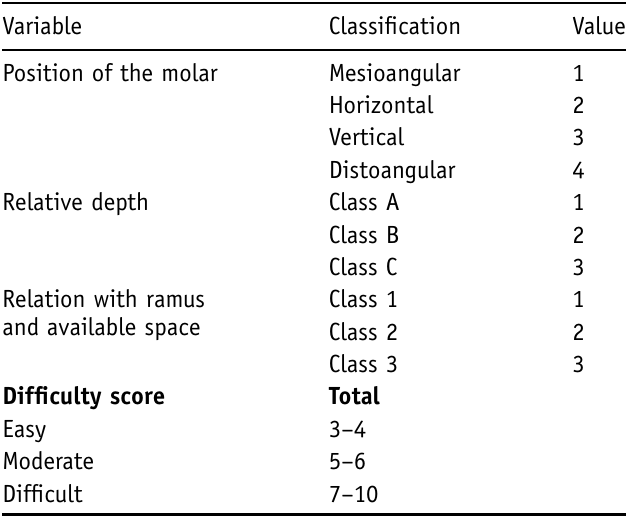
Table I. Pederson dif fi culty index [11]. Table II. The Pernambuco index